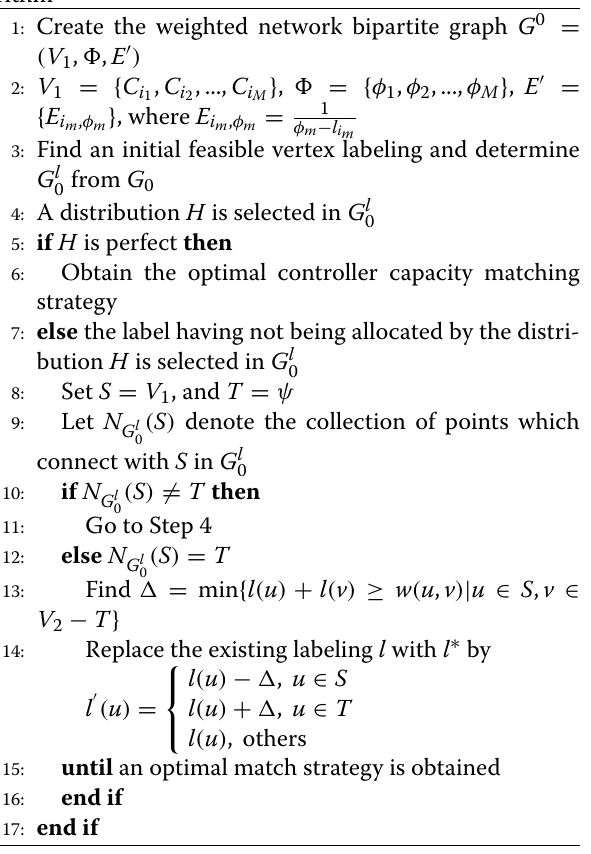
Algorithm 2 Proposed controller capacity matching algo-